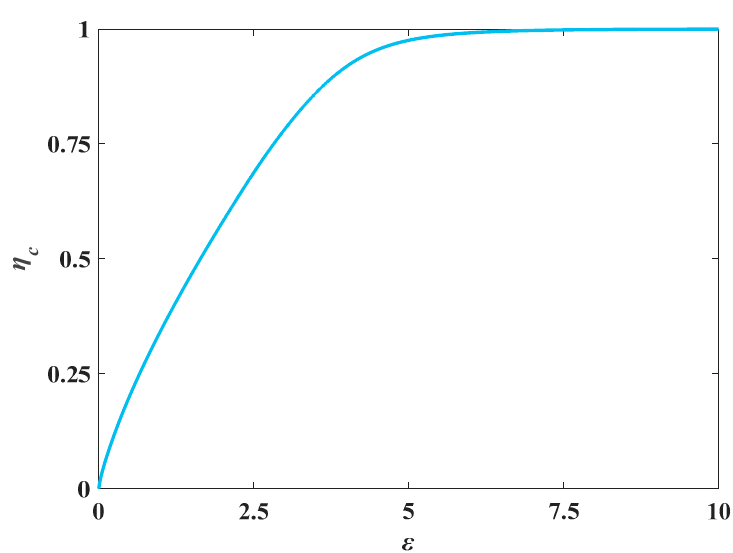
Figure 6. The relation curve between the ε and η e functions of an egg-shaped section.